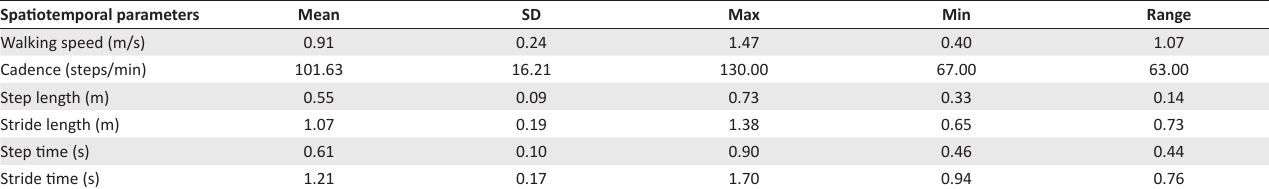
TABLE 1: Mean and standard deviation group spatiotemporal parameters. Spatiotemporal parameters